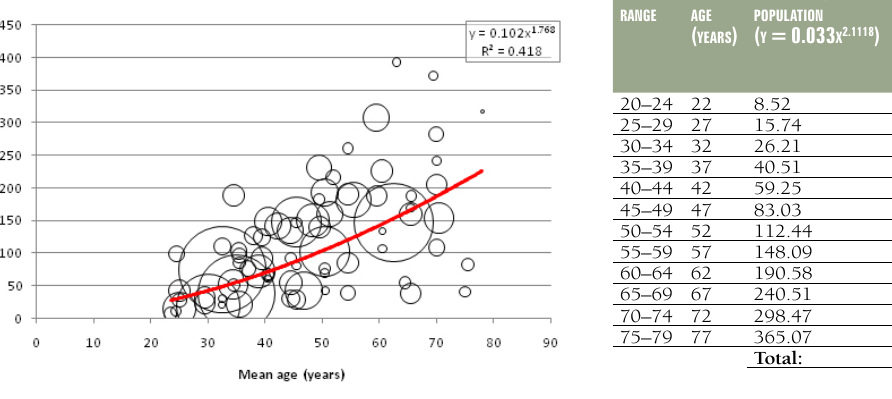
Figure 16. Relationship between crude prevalence of type 2 diabetes and age in Southern Asia based on the studies using FPG only in their case definition. FPG – fasting plasma glucose.